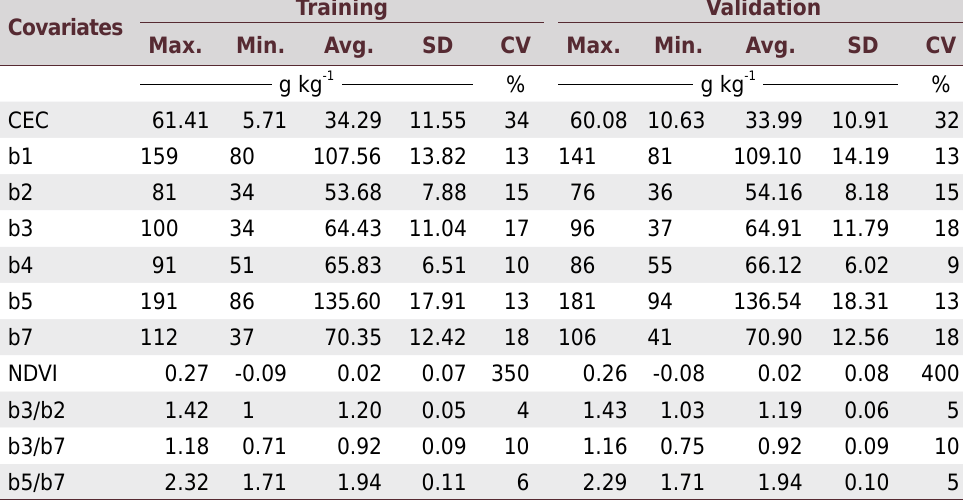
Table 1. Descriptive statistics of soil samples, training and validation datasets, and covariates used to predict soil CEC Training Validation Covariates